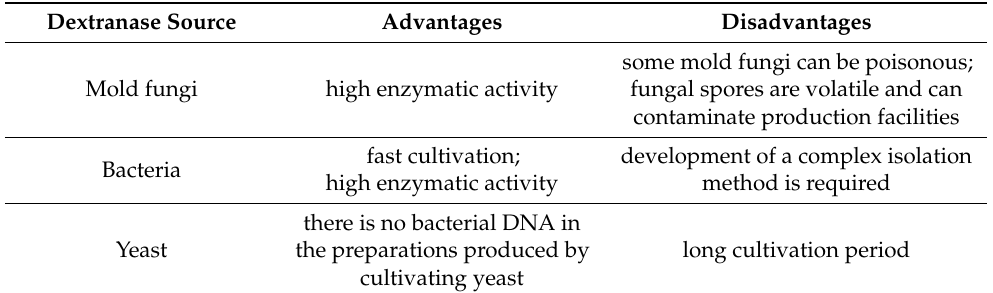
Table 4. Comparative characteristics of sources for producing dextranase according to the results of the analysis of literature